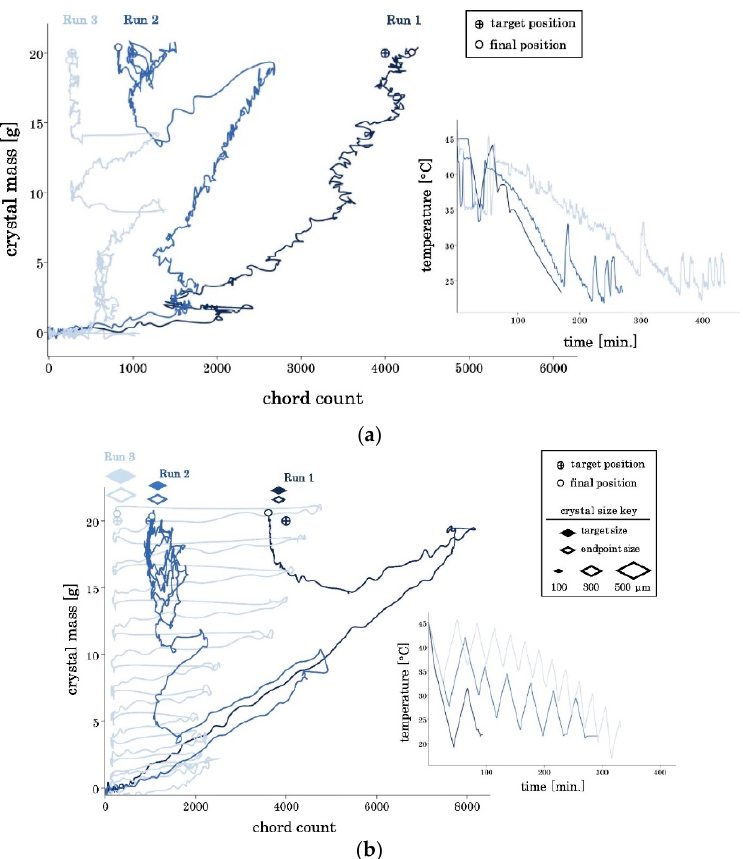
Figure 13. Model-based control results ( a ); Rule-based control results ( b ). Summary of the mass- count trajectories achieved with the given feedback control scheme. For each target, the measured mass-average crystal size is shown visually against the target size. Inset: implemented temperature profiles. (Caption and figure reprinted with permission from Reference [39]).